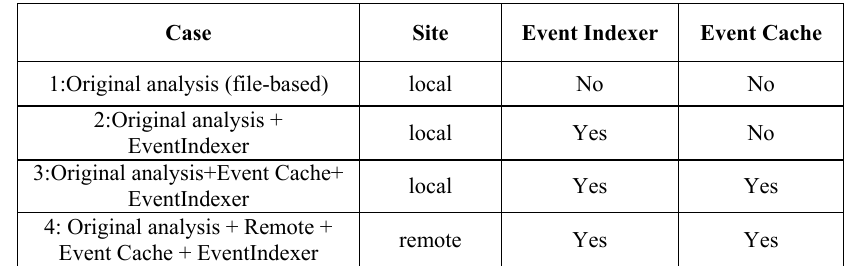
Fig. 5. The architecture of event-oriented data transfer service.